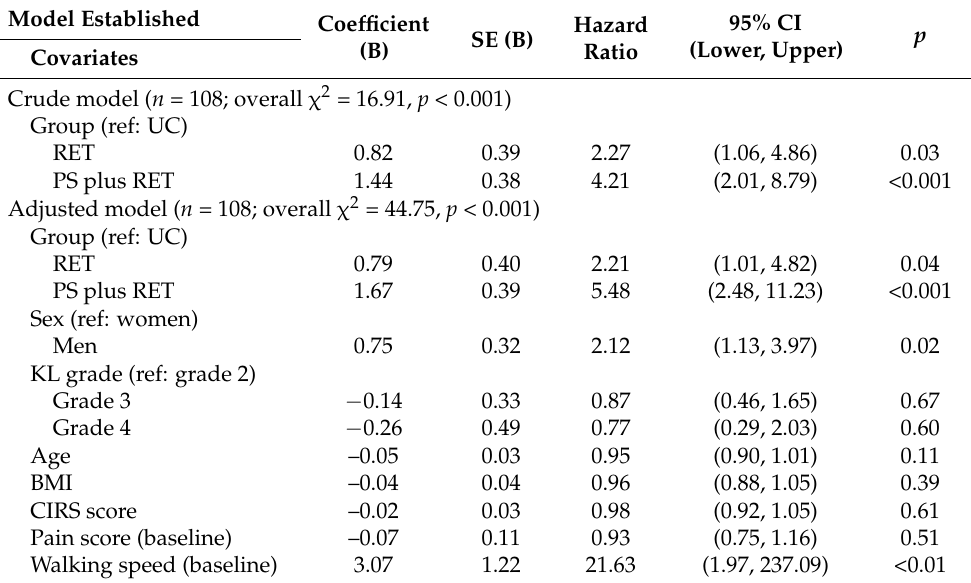
SE, standard error; 95% CI, 95% confidence interval; UC, usual care; RET, resistance exercise training; PS, protein supplementation; KL grade, Kellgren–Lawrence grade; BMI, body mass index; CIRS, Cumulative Illness Rating